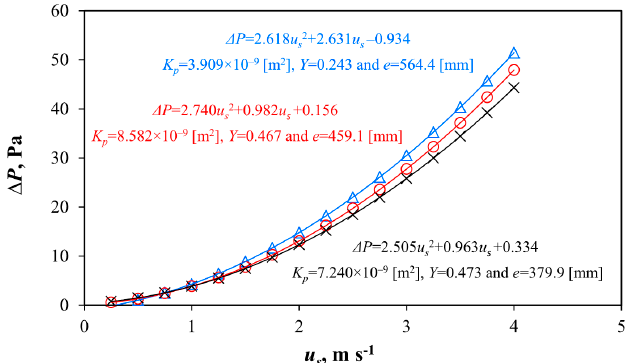
Figure 4. Pressure drops Δ P (Pa) in function of air velocity through screen u s (m·s − 1 ), determined by